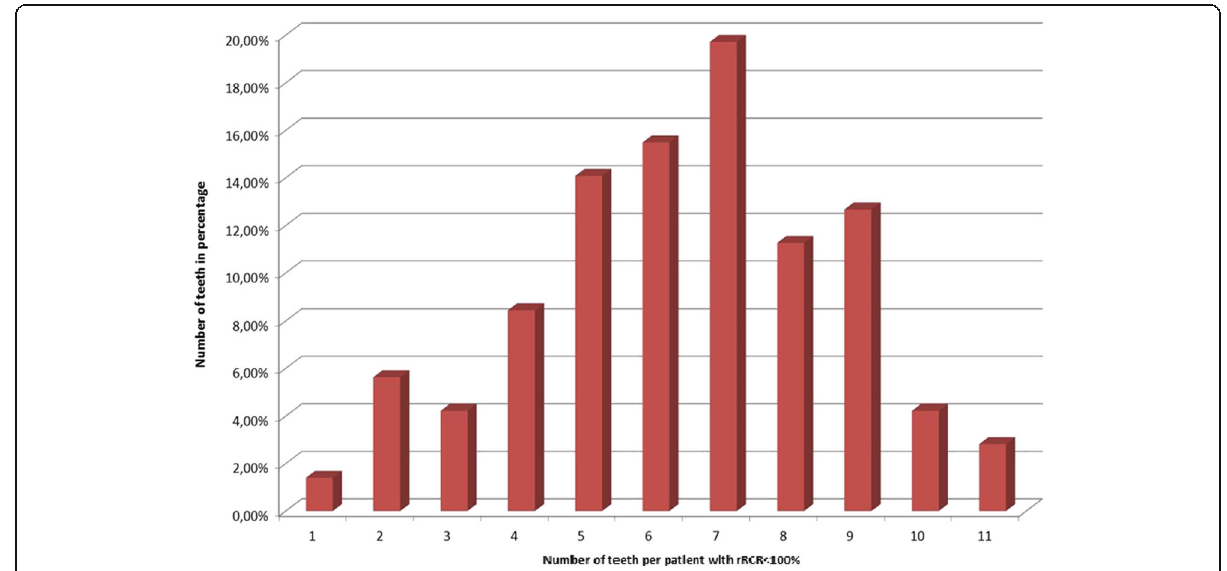
Fig. 2 Distribution of the amount of affected teeth per patient